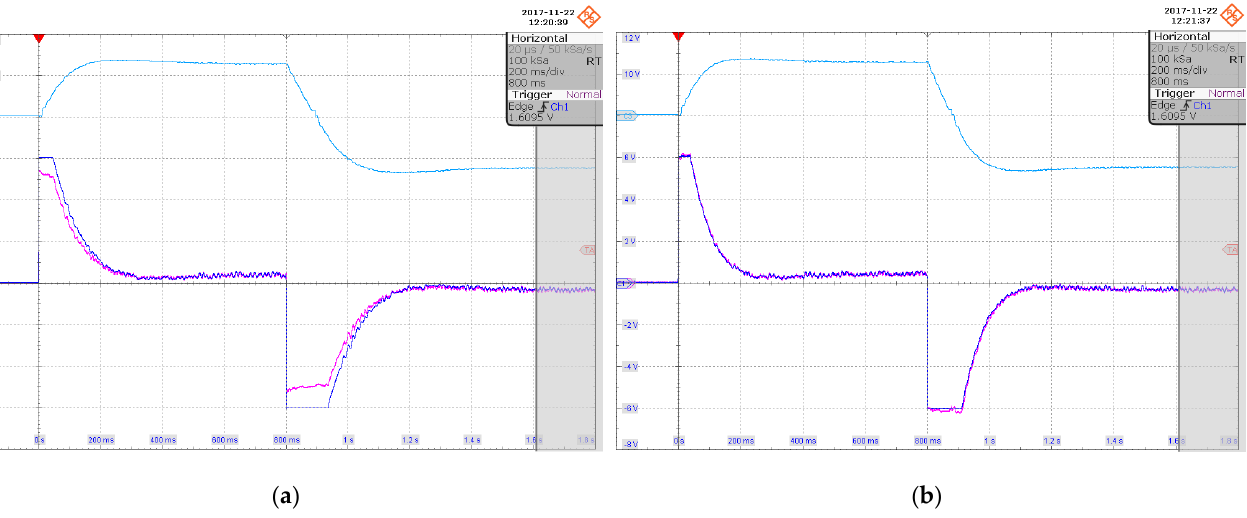
Figure 11. Experimental results: acceleration from 0 to 500 rpm and reversal, actual rotor speed (light blue), the reference (dark blue) and actual (pink) torque-producing stator current, total moment of inertia of J t = J M = 0.013 kgm 2 (induction motor only), current scale 2 A/div, speed scale 400 rpm/div, time scale 200 ms/div; ( a ) without decoupling; ( b ) with decoupling.